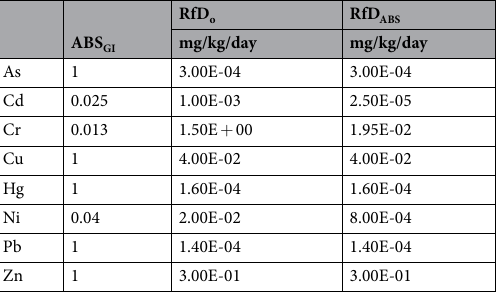
Table 5. Reference dose (RfD) values of heavy metals 29 . Reference doses are not available for dermal absorption exposure to contaminants, RfD ABS is calculated by using RfD ABS = RfD o × ABS GI where RfD ABS is the dermally adjusted reference dose (mg/kg/day), RfDo is the oral reference dose (mg/kg/day), and ABS GI is the gastrointestinal absorption factor (unitless) 30